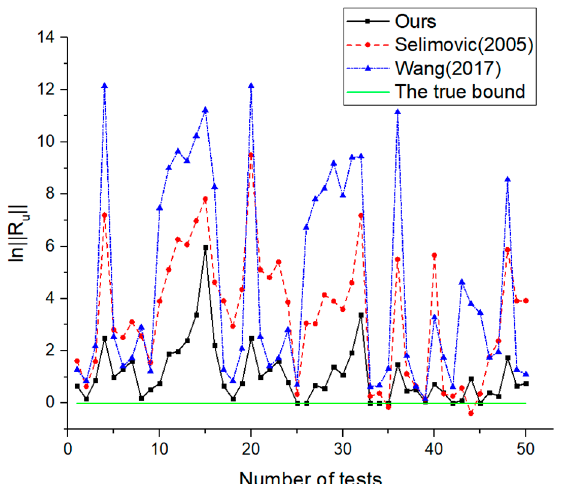
( ) R u of NURBS surfaces with ( ) u R u of NURBS surfaces with u